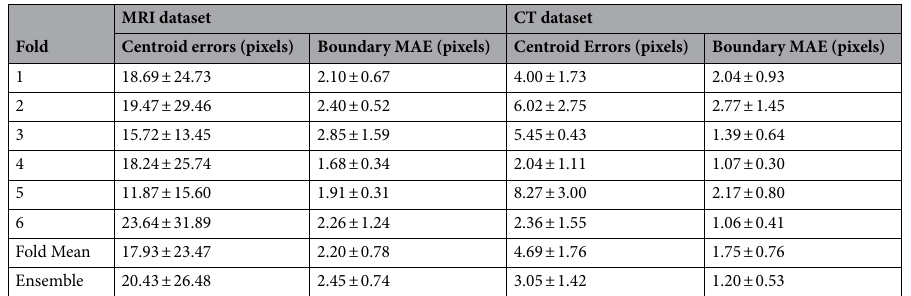
Table 1. Results summary with the mean ± standard deviation for centroid and boundary errors for the MRI and CT datasets. MAE indicates the mean absolute error. The values for the individual folds are presented along with their mean and the ensemble (based on majority voting).